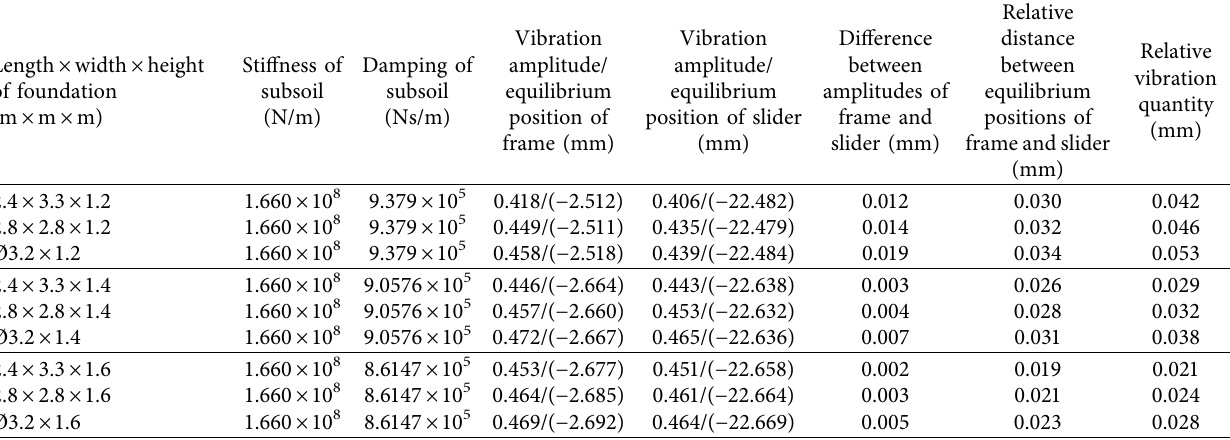
Table 2: Vibration quantity of punching press under a series of foundations with a variable depth (mm).